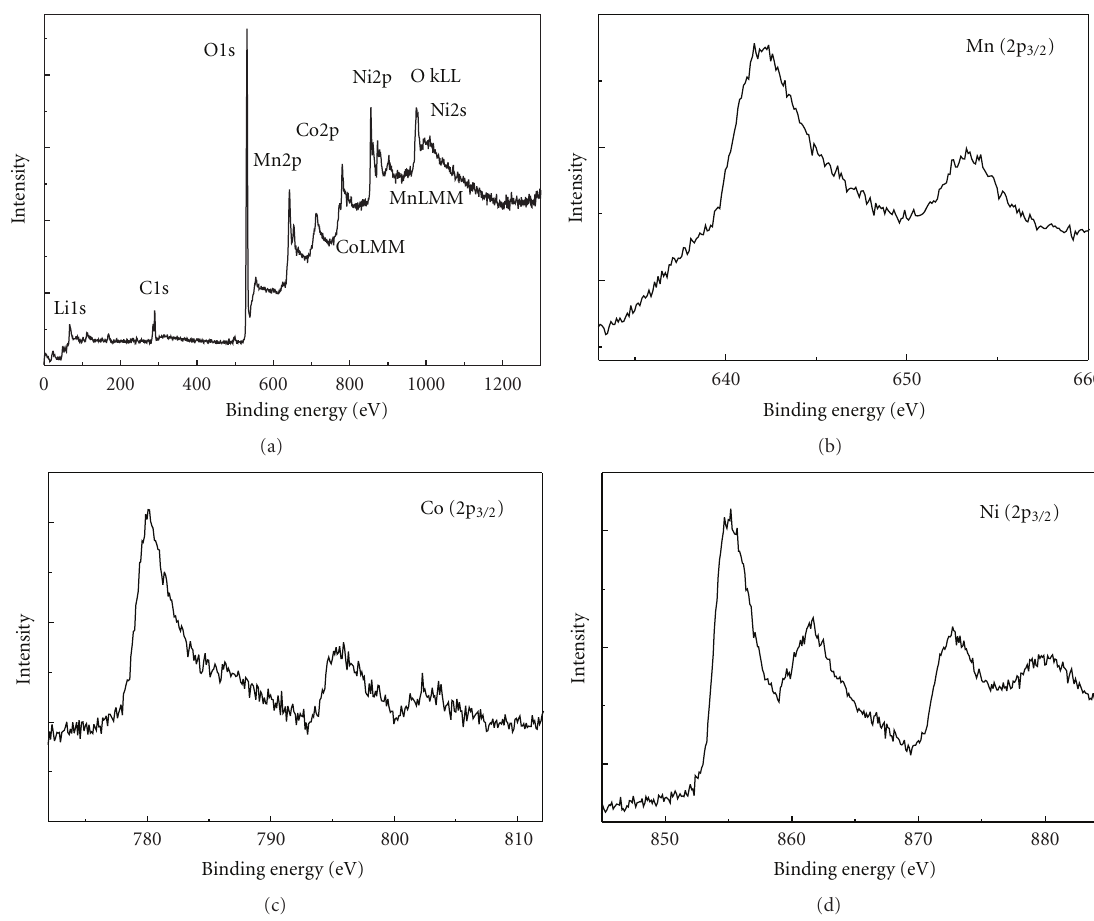
Figure 3: XPS emission spectra of (a) Li[Ni 0 . 5 Mn 0 . 3 Co 0 . 2 ]O 2 and magnified (b) Mn 2p 3 / 2 , (c) Co 2p 3 / 2 , and (d) Ni 2p 3 / 2